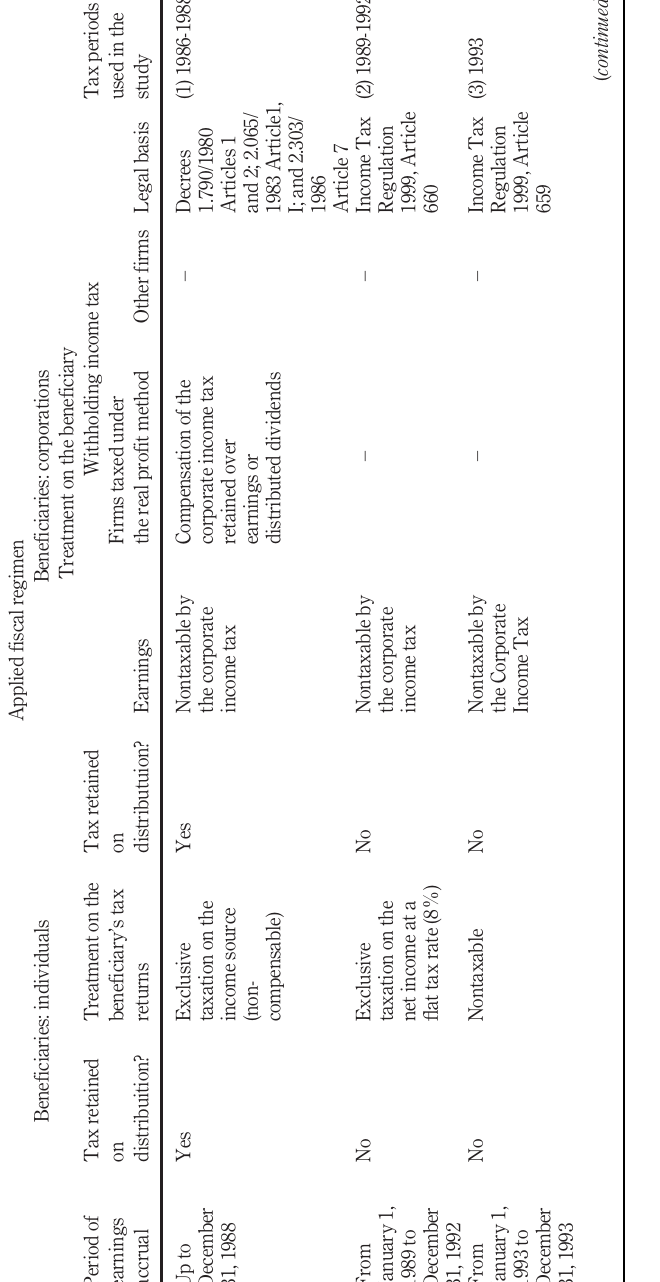
Table I. Summary of